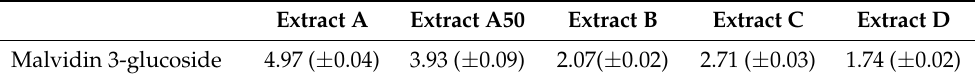
Table 18 reports the absolute concentrations of malvidin 3-glucoside in all the extracts. Table 18. Malvidin 3-glucoside absolute concentrations ( µ g/mL, mean ± SD) in the